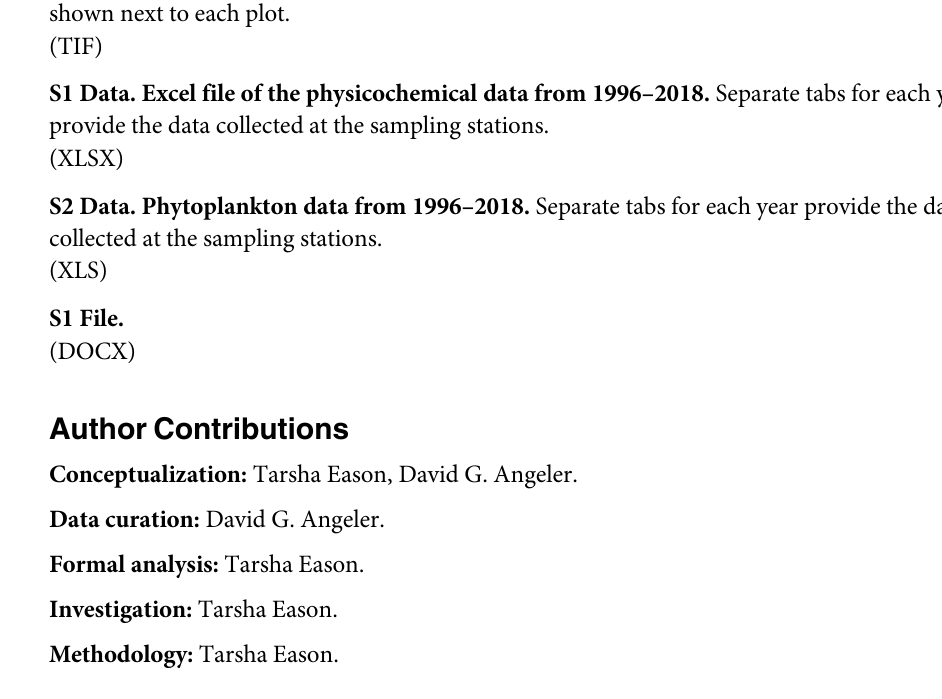
low to high FI values over the landscape and the mean ( μ ) and standard deviation ( σ ) of FI are shown next to each plot. S2 Fig. GIS plots of the Fisher information results computed from the 2004–2011 physico- chemical data. A blue to red color scheme and marker size gradient are used to distinguish low to high FI values over the landscape and the mean ( μ ) and standard deviation ( σ ) of FI are shown next to each plot. S3 Fig. GIS plots of the Fisher information results computed from the 2012–2018 physico- chemical data. A blue to red color scheme and marker size gradient are used to distinguish low to high FI values over the landscape and the mean ( μ ) and standard deviation ( σ ) of FI are shown next to each plot. S4 Fig. GIS plots of the Fisher information results computed from the 1996–2003 phyto- plankton data. A blue to red color scheme and marker size gradient are used to distinguish low to high FI values over the landscape and the mean ( μ ) and standard deviation ( σ ) of FI are shown next to each plot. S5 Fig. GIS plots of the Fisher information results computed from the 2004–2011 phyto- plankton data. A blue to red color scheme and marker size gradient are used to distinguish low to high FI values over the landscape and the mean ( μ ) and standard deviation ( σ ) of FI are shown next to each plot. S6 Fig. GIS plots of the Fisher information results computed from the 2012–2018 phyto- plankton data. A blue to red color scheme and marker size gradient are used to distinguish low to high FI values over the landscape and the mean ( μ ) and standard deviation ( σ ) of FI are shown next to each plot. S1 Data. Excel file of the physicochemical data from 1996–2018. Separate tabs for each year provide the data collected at the sampling stations. S2 Data. Phytoplankton data from 1996–2018. Separate tabs for each year provide the data collected at the sampling